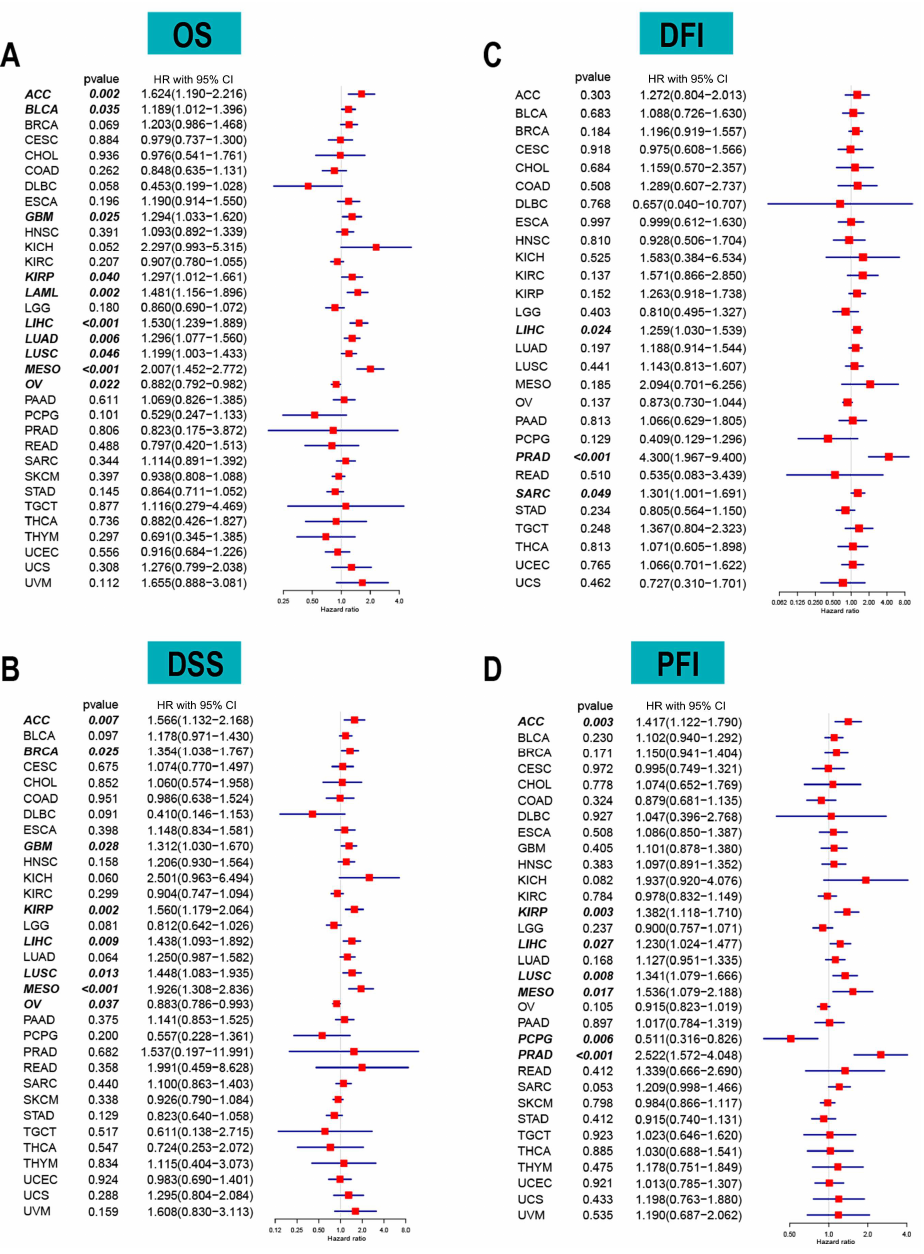
Figure 2. Forest plots based on univariate Cox regression analyses to show the relationship between ACOT7 mRNA expression and ( A ) overall survival (OS), ( B ) disease-free interval (DFI), ( C ) disease- specific survival (DSS), and ( D ) progression-free interval (PFI).